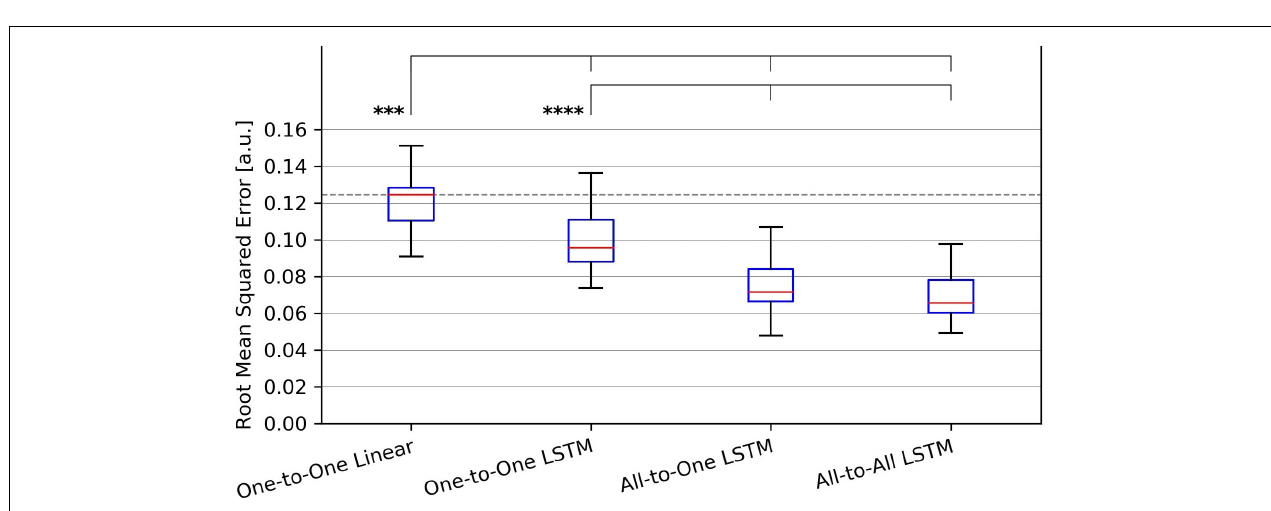
FIGURE 2 | An example (from a random subject) of input iEMG presented to, and output force estimates produced by, all regression models, together with synchronous ground truth force measurements. Segments of iEMG channels (columns) and paired force channels shown here were selected from the task of the recording protocol in which they were maximally correlated; as such, the columns do not represent mutually concurrent time intervals in this illustration.